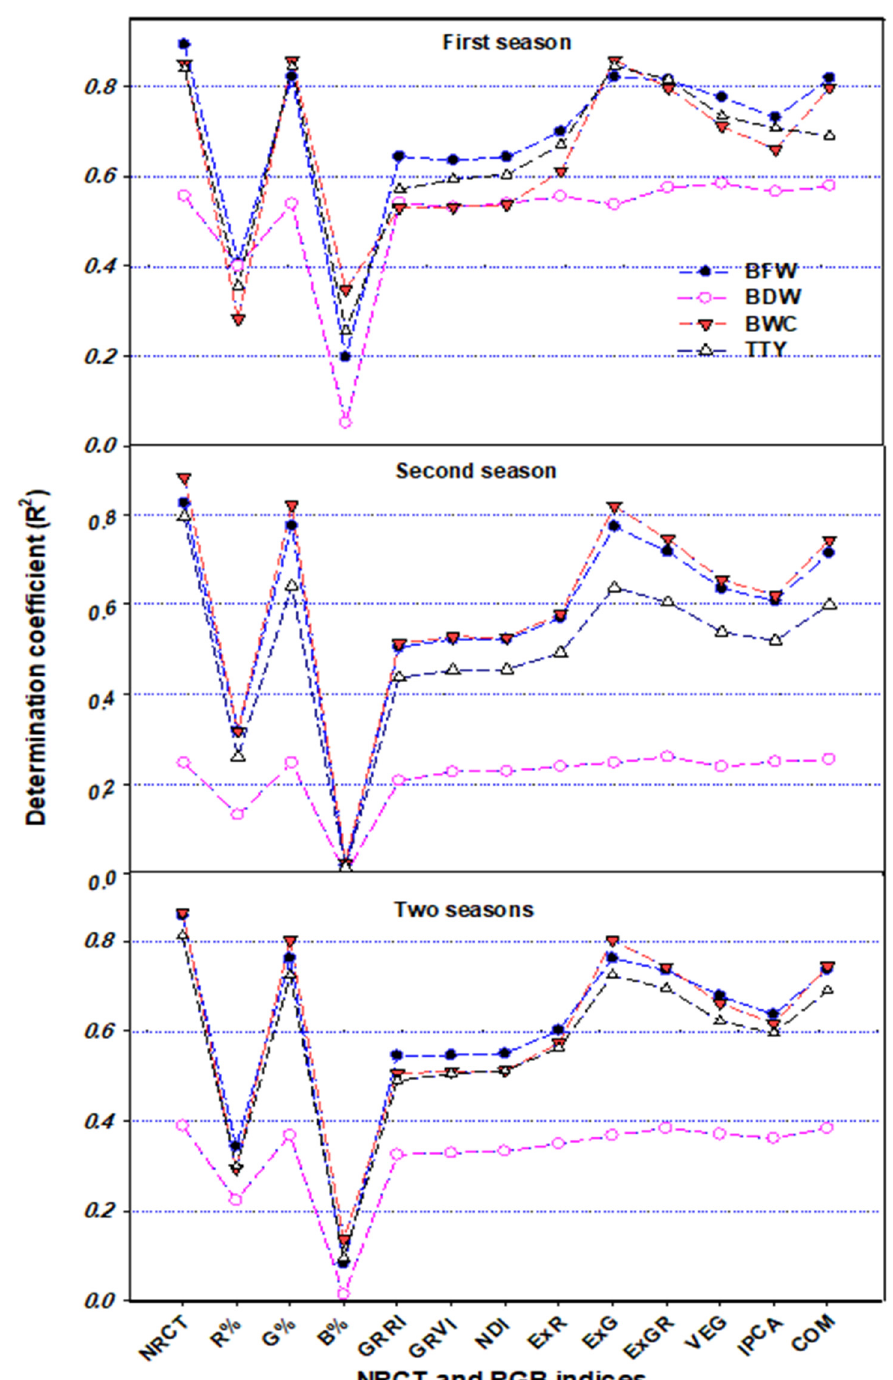
Figure 9. The determination coefficients of relationships between the NRCT and twelve RGB imagery indices with biomass fresh weight (BFW), biomass dry weight (BDW), biomass water content (BWC), and total tuber yield (TTY) of two potato varieties subjected to different irrigation regimes for each season and across two seasons. R 2 values ≥ 0.48 are significant at p ≤ 0.05. The full names of the abbreviations of RGB imagery indices are listed in Table 1.